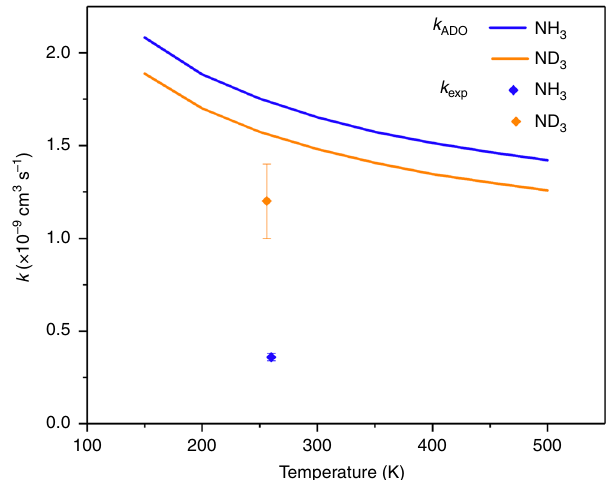
Fig. 2 Charge exchange rate constants. Comparison between experimentally measured reaction rate constants and those predicted by the ADO model for the charge exchange reaction between Xe þ and NH 3 (blue) or ND 3 (orange). Error bars indicate the uncertainty in the experimental rate constants. See Supplementary Note 4, Supplementary Fig. 1 and Supplementary Table 2 for further